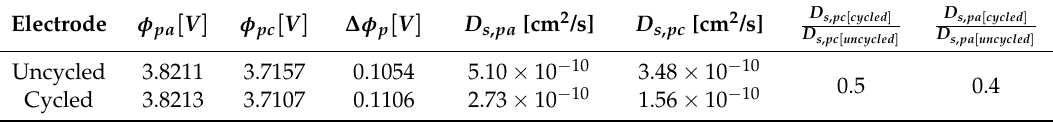
Table 4. Redox peaks characteristics of NMC uncycled and cycled electrodes.